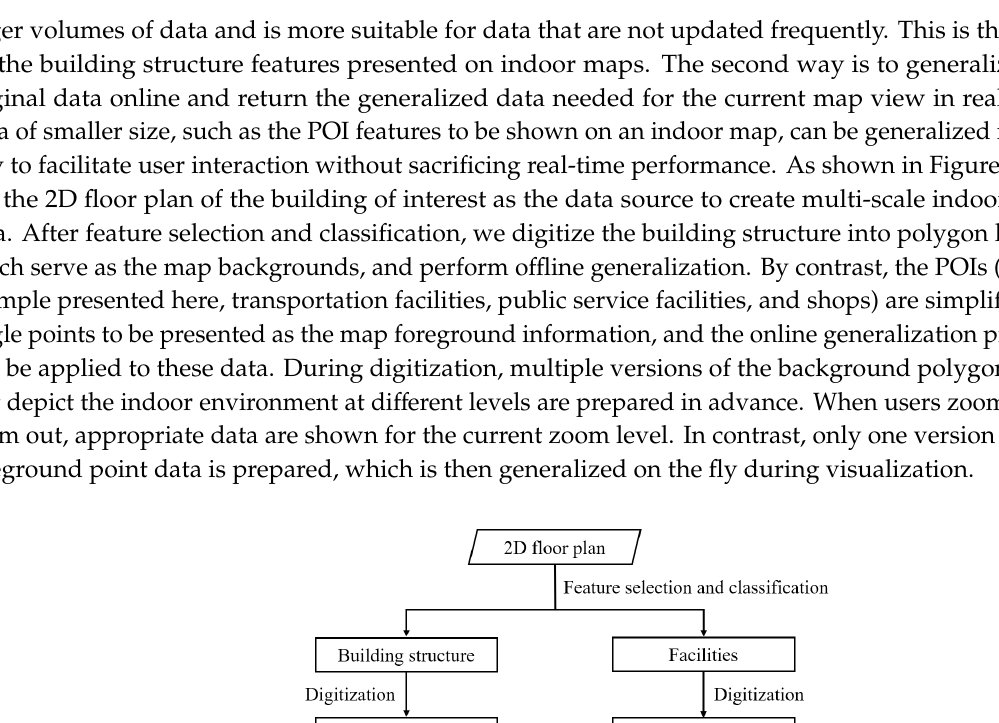
Table 2. LOD specifications for building structures.